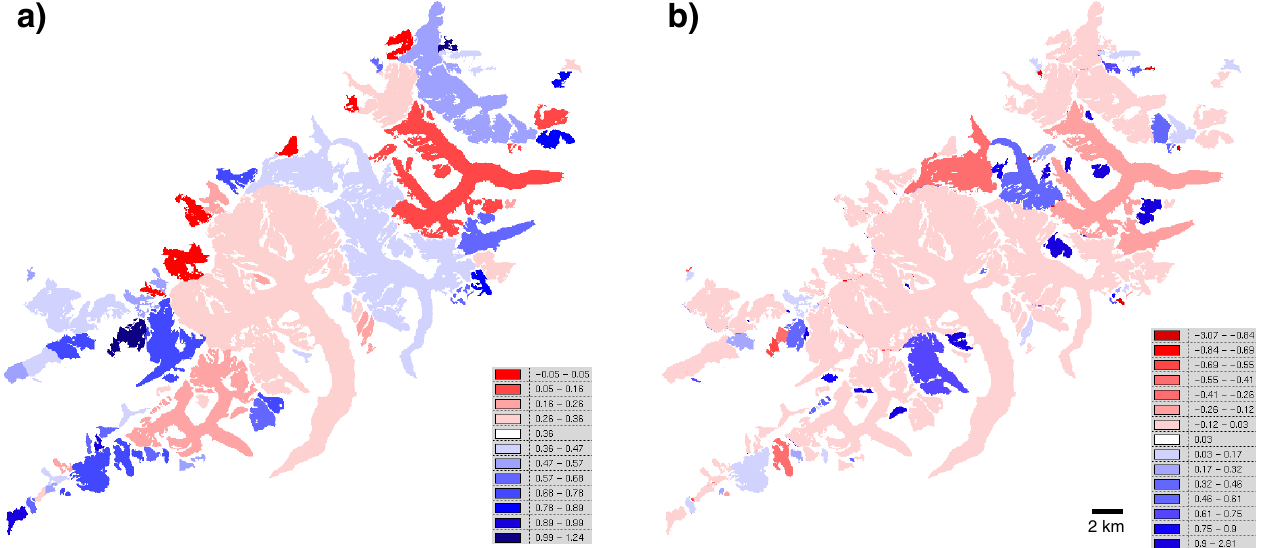
Fig. 5. (a) Change in mean mass balance due to a change of the DEM and glacier extent (difference 3). (b) As Fig. 5a, but here the change in mean mass balance considers glacier split (difference 4).